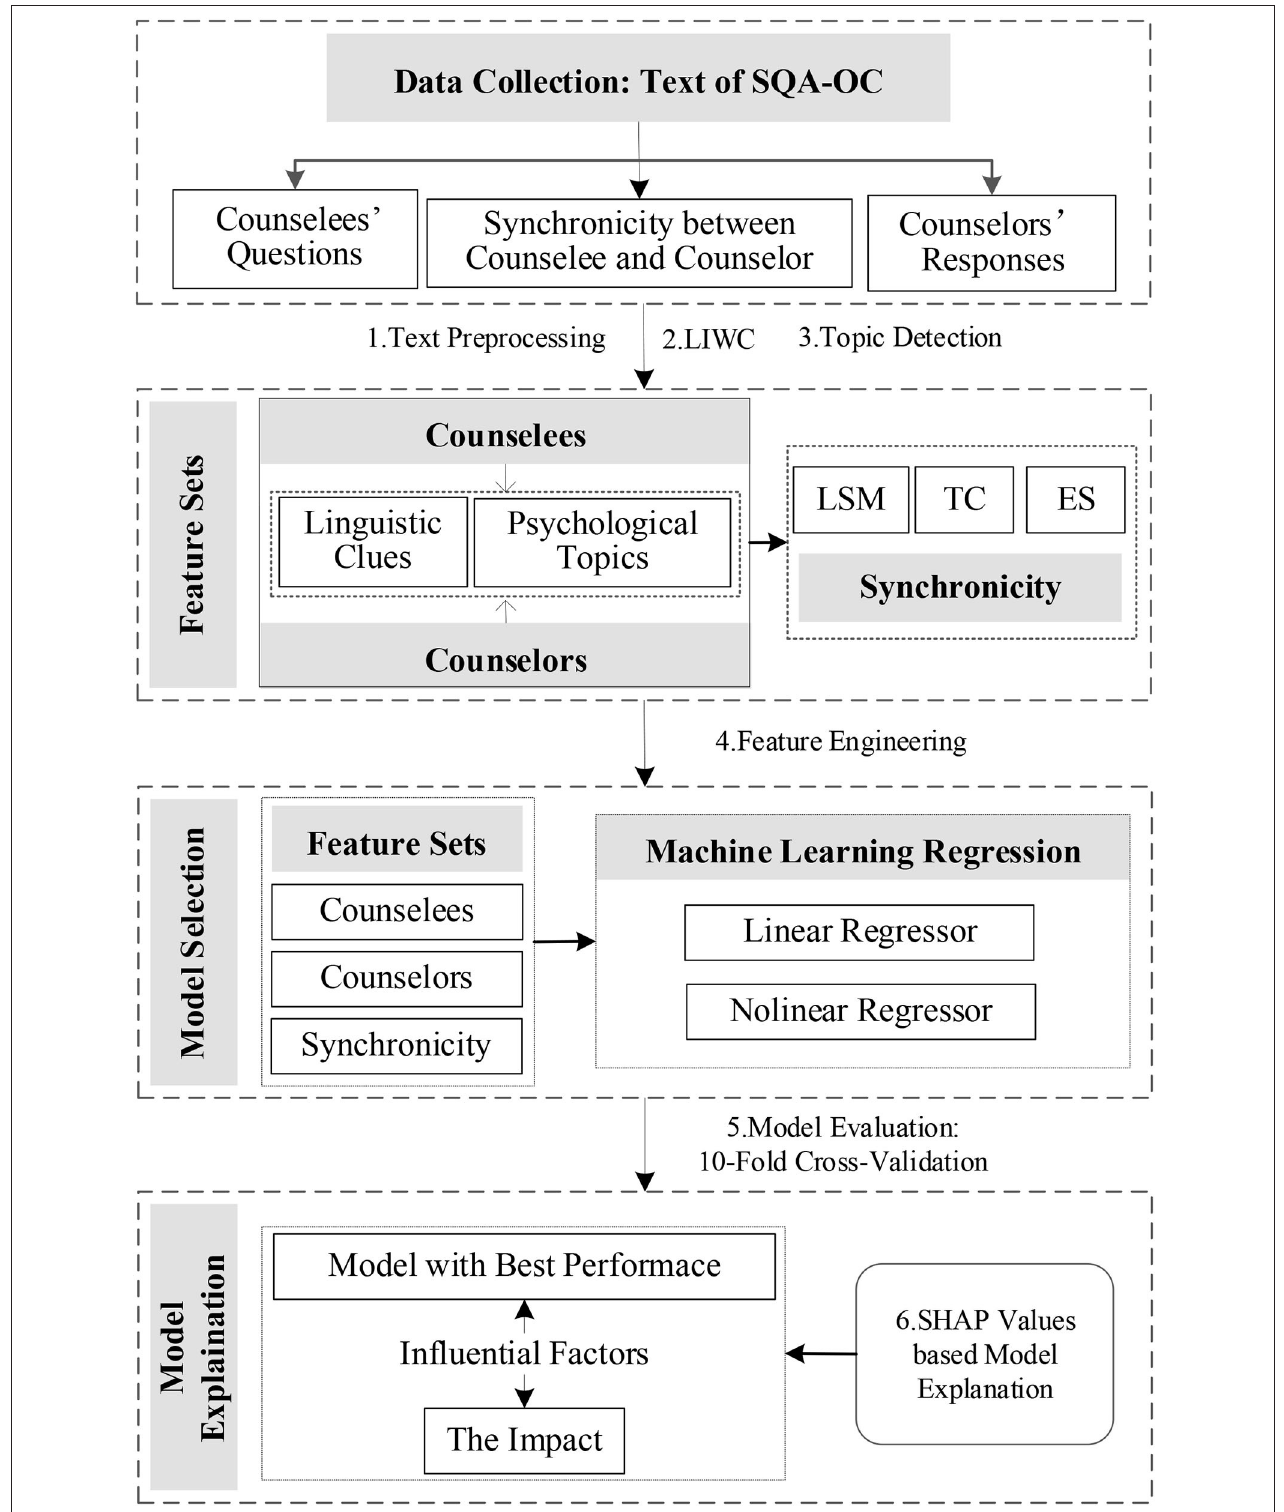
FIGURE 1 | Research methods and